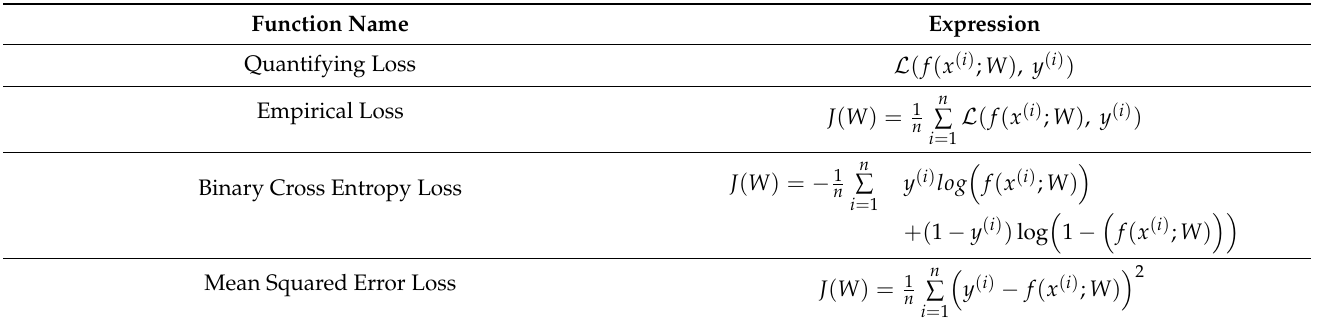
Table 2. Loss functions for NN.